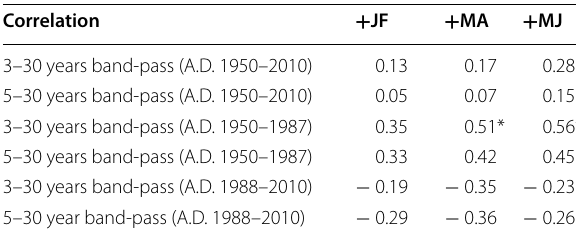
Table 3 Correlation coefficients between inverted MJ